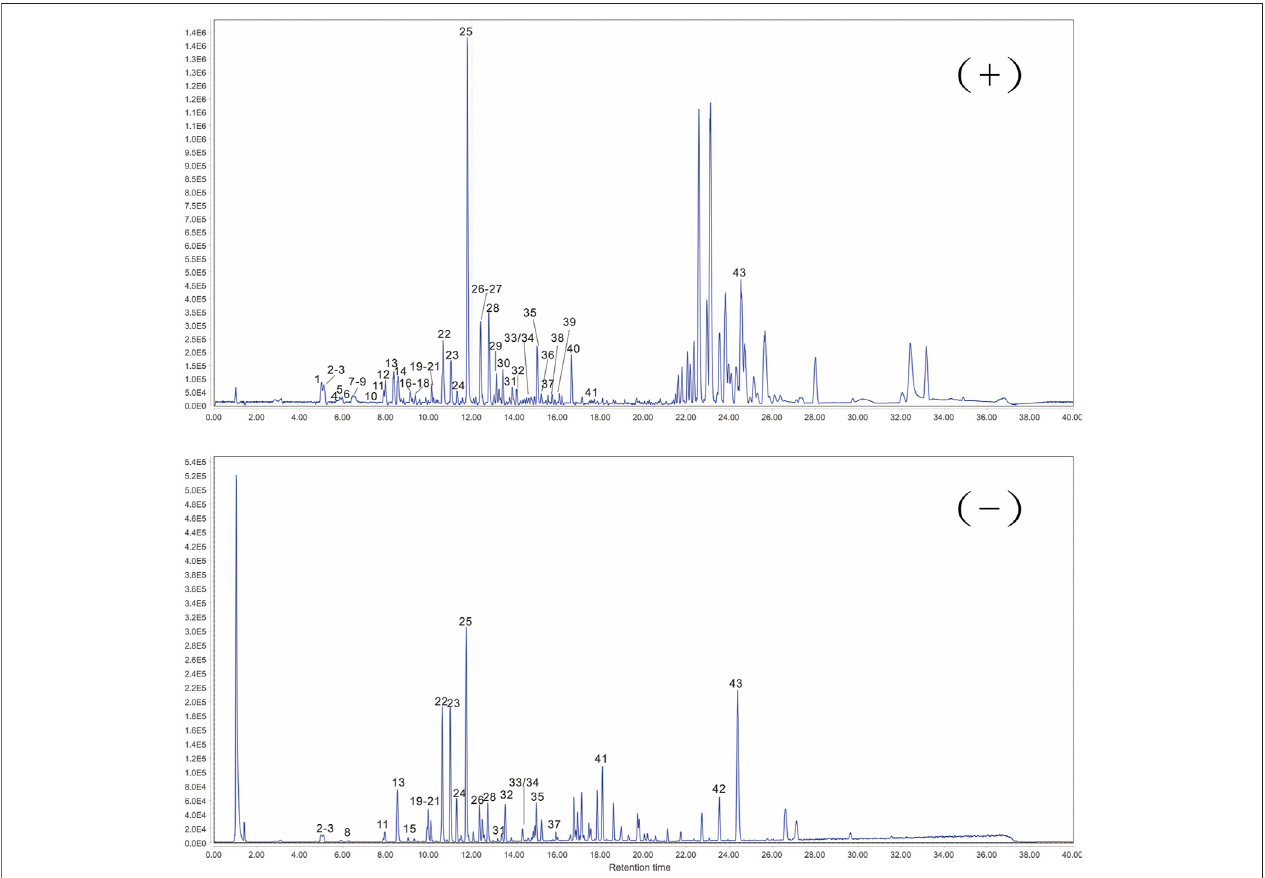
FIGURE 2 | Representative base peak chromatogram of ARC in positive and negative ionization mode, respectively.